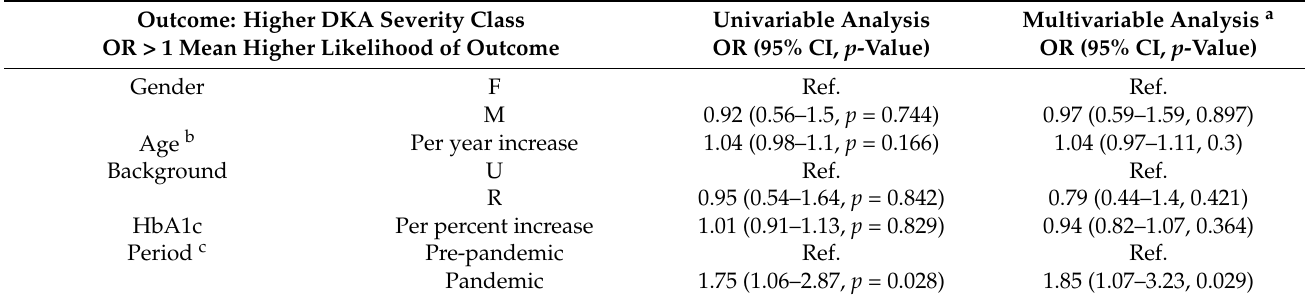
Table 6. Proportional odds logistic regression of variables associated with increased DKA